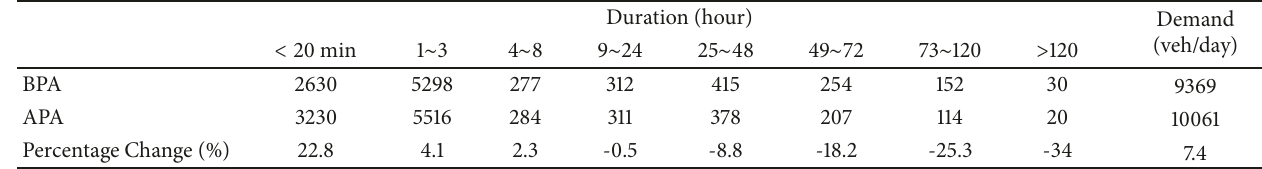
Table 3: Parking demand variation before and after price adjustment.